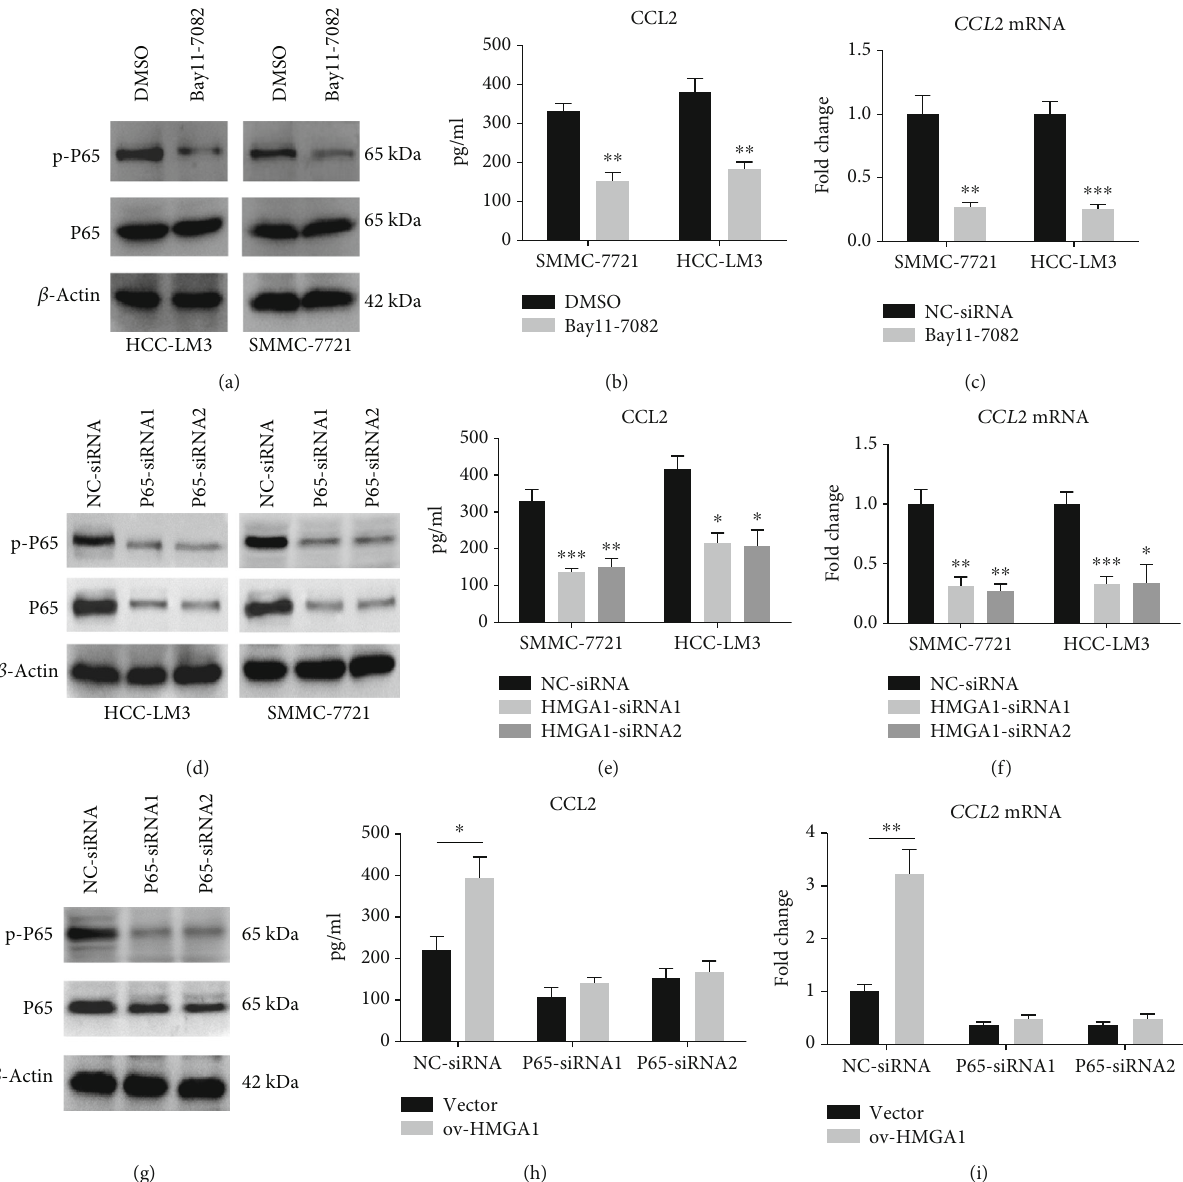
Figure 4: HMGA1 regulates CCL2 expression in an NF- κ B-dependent manner. (a) Western blotting analysis showed the total and phosphorylated level of P65 in HCC-LM3 and SMC-7721 cells after treatment with NF- κ B inhibitor Bay11-7082 (10 μ M). (b) ELISA analysis showed the secreted level of CCL2 in the conditioned medium (CM) of HCC-LM3 and SMC-7721 cells after treatment with 10 μ M Bay11-7082 for 24 h. (c) Real-time qPCR analysis showed the mRNA level of CCL2 in the HCC-LM3 and SMC-7721 cells after treatment with 10 μ M Bay11-7082 for 24 h. (d) Western blotting analysis showed the total and phosphorylated level of P65 in HCC-LM3 and SMC-7721 cells after treatment with speci fi c siRNAs against P65. (e) ELISA analysis showed the secreted level of CCL2 in the conditioned medium (CM) of HCC-LM3 and SMC-7721 cells after treatment with speci fi c P65 siRNAs for 48h. (f) Real-time qPCR analysis showed the mRNA level of CCL2 in the HCC-LM3 and SMC-7721 cells after treatment with speci fi c P65 siRNAs for 48h. (g) Western blotting analysis showed the total and phosphorylated level of P65 in SNU-423 cells after treatment with speci fi c siRNAs against P65. (h) ELISA analysis showed the secreted level of CCL2 in the conditioned medium (CM) of ov-vector and ov-HMGA1 SNU- 423 cells after treatment with speci fi c P65 siRNAs for 48h. (i) Real-time qPCR analysis showed the mRNA level of CCL2 in the ov- vector and ov-HMGA1 SNU-423 cells after treatment with speci fi c P65 siRNAs for 48h. The ANOVA followed by post hoc Tukey ’ s multiple comparison test or the Student ’ s t -test was used for group comparisons. ∗ P < 0 : 05 ; ∗∗ P < 0 : 01 ; ∗∗∗ P < 0 : 001